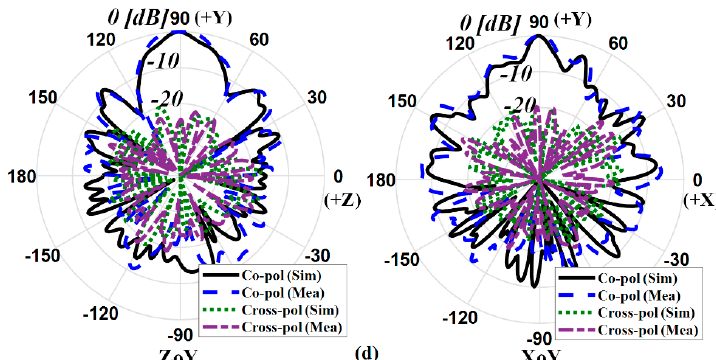
Figure 12. Simulated and measured radiation patterns of the designed antenna in ZY (H-plane) and XY (E-plane) at ( a ) 0.7 GHz, ( b ) 2.4 GHz, ( c ) 5.8 GHz and ( d ) 10 GHz.